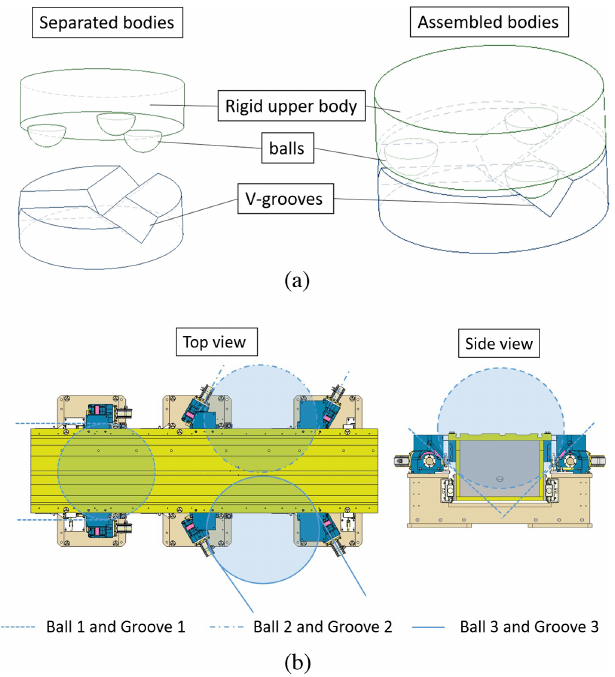
FIG. 8. Kinetic design principle of the prototype: (a) diagram of Boyes clamp and (b) assumed balls and grooves.